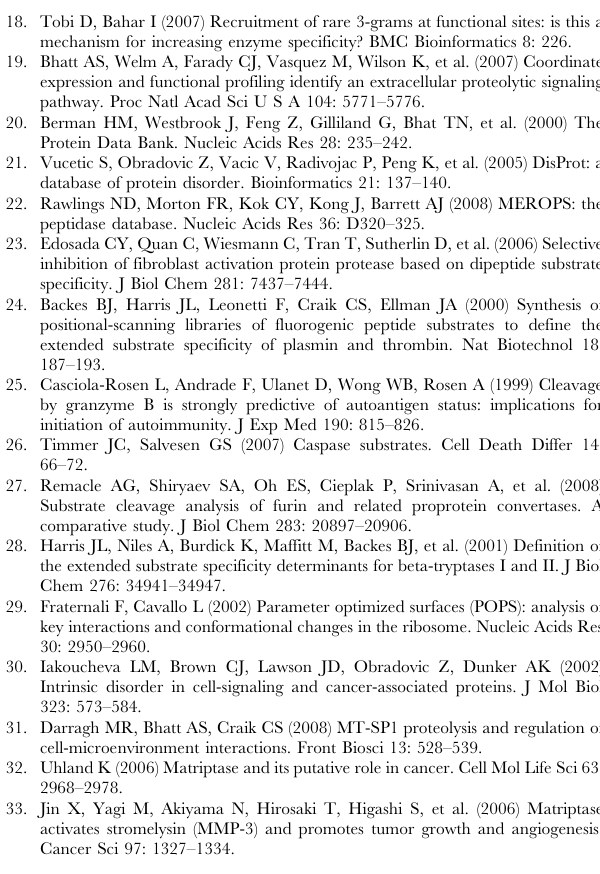
Table S6 Potential Substrates of Serine Proteases from the PDB and DisProt